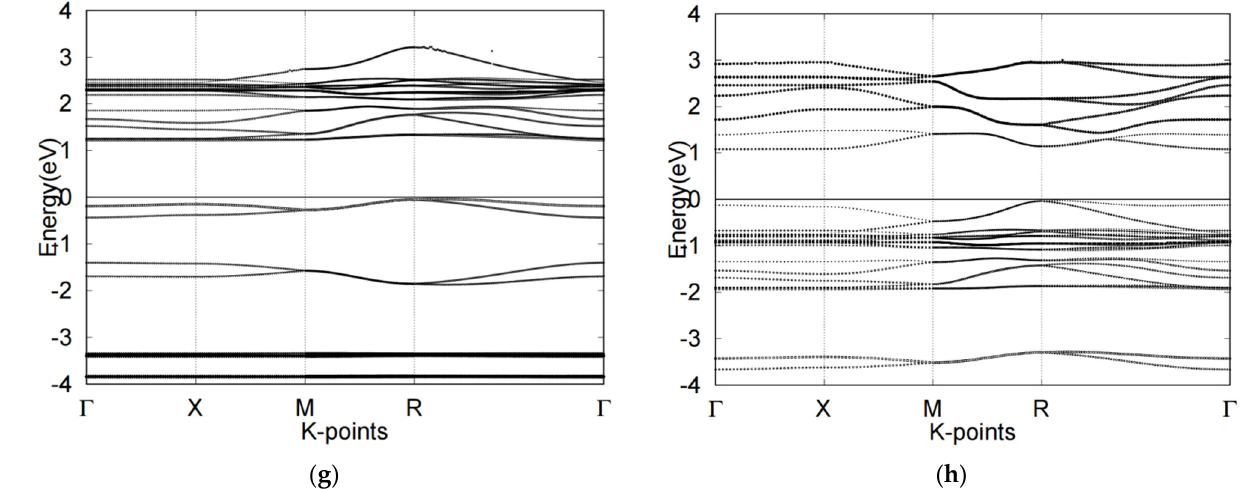
Figure 5. Atomic structures of ( a ) Cs 4 Sn 4 Cl 6 I 6 ( b ) Cs 2 Sn 2 Cl 3 I 3 Sr 2 TiRhO 6 ( c ) Cs 2 Sn 2 Cl 6 Sr 2 Ti 2 O 6 and ( d ) CsSnCl 3 Sr 3 Ti 2 RhO 12 mixed perovskite compounds were displayed along with the labels of the atoms. Electronic band structure of compounds ( e ) Cs 4 Sn 4 Cl 6 I 6 ( f ) Cs 2 Sn 2 Cl 3 I 3 Sr 2 TiRhO 6 ( g ) Cs 2 Sn 2 Cl 6 Sr 2 Ti 2 O 6 ( h ) CsSnCl 3 Sr 3 Ti 2 RhO 12 were also presented with various bandgaps.